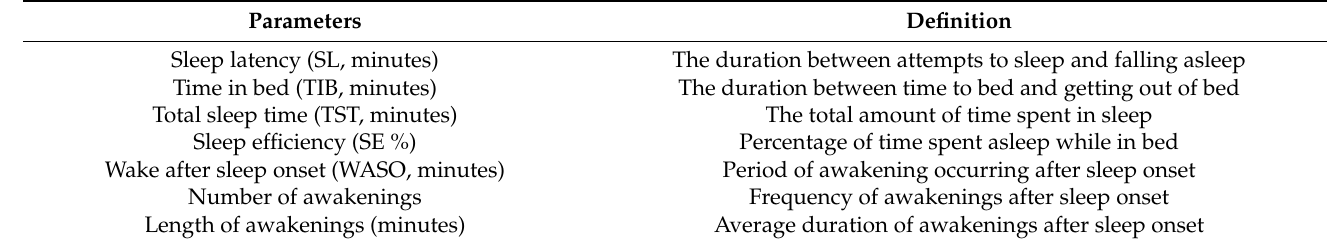
Table 2. Parameters of sleep